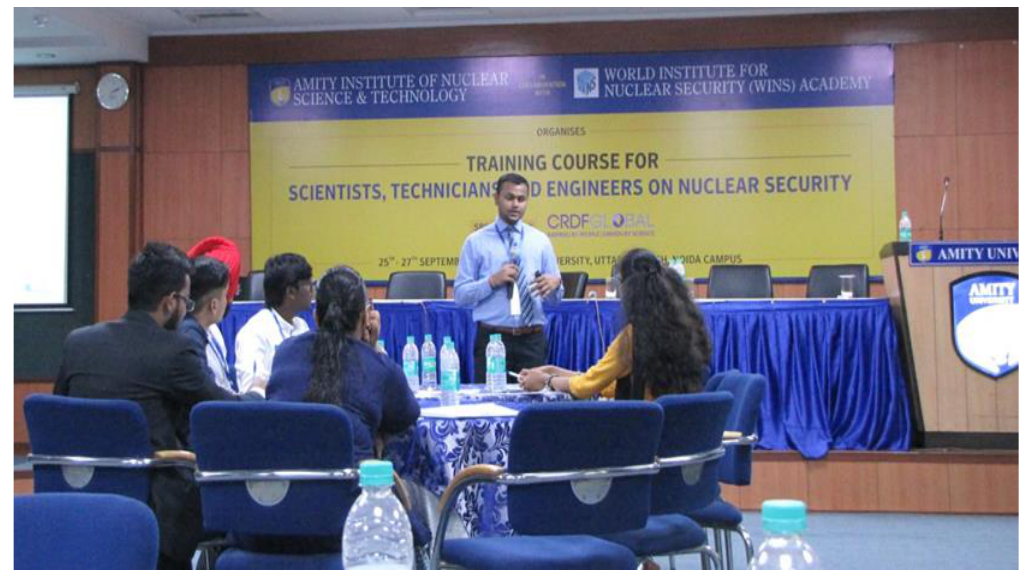
Picture 7. Dr. Manit Shah from ORNL with the participants during “Table-top Exercise (TTX) on insider threat” in WINS Academy Training